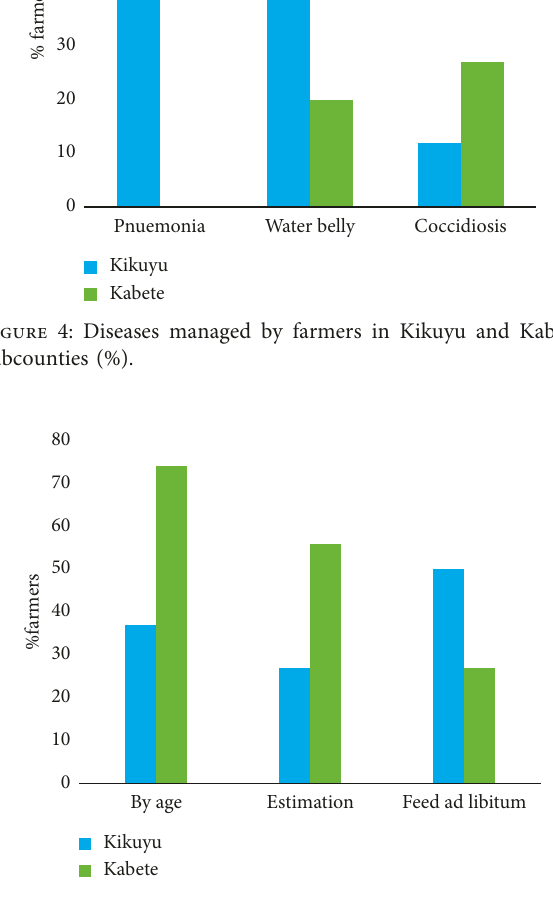
Figure 5: Ways farmers used to determine the amount of feed to their